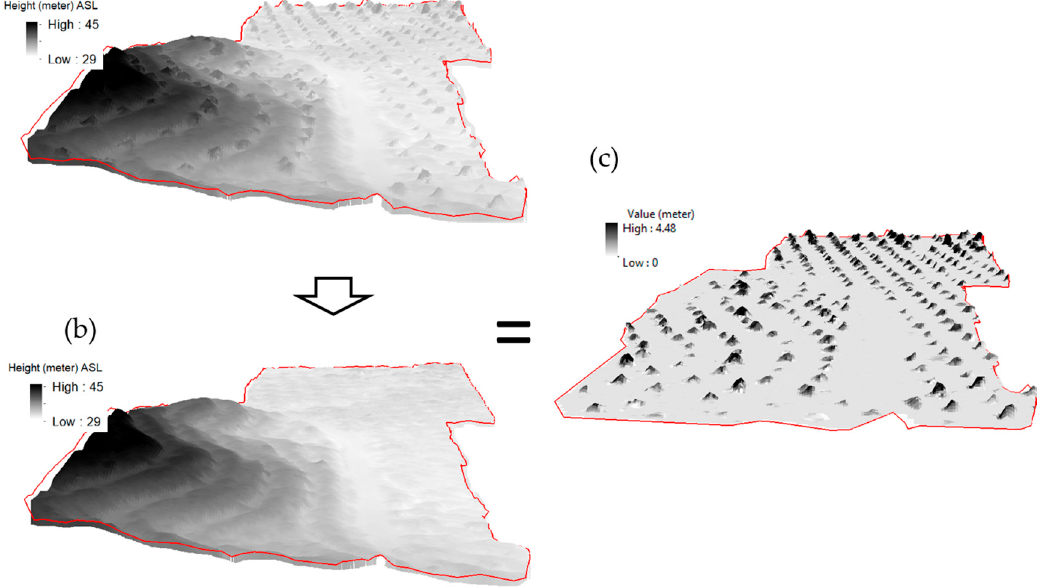
Figure 7. 3D view of ( a ) DSM subtracted using ( b ) DEM to produce ( c ) CHM.